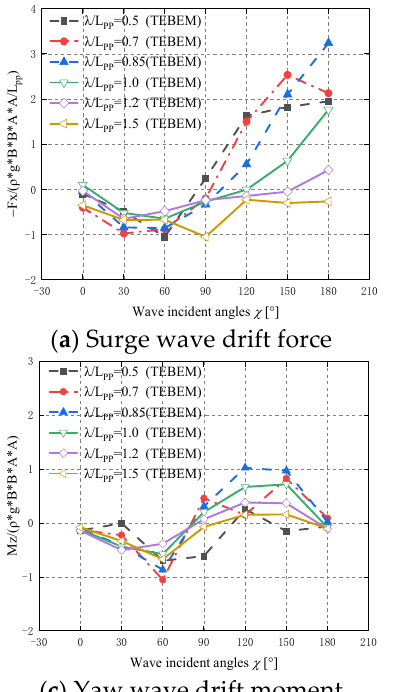
Table 2. Related coefficients used in the simulation. Coefficient Value